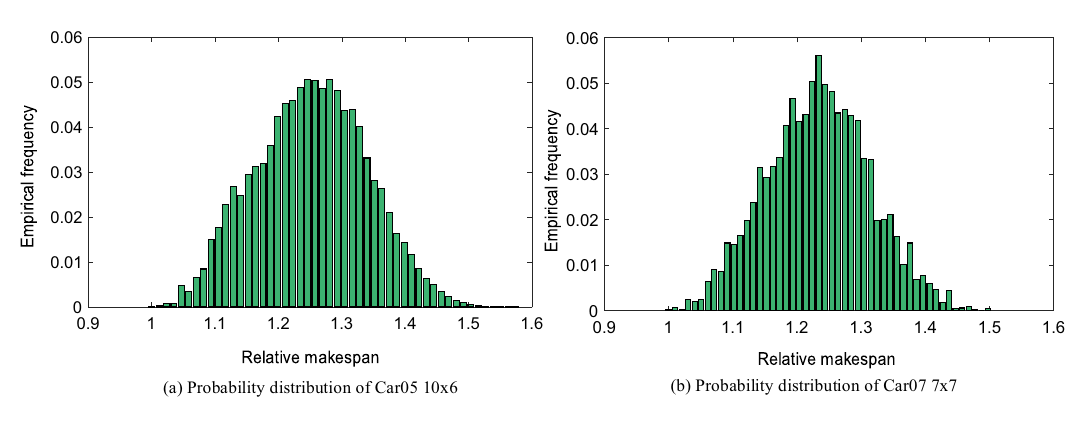
Figure 2. Probability distribution of